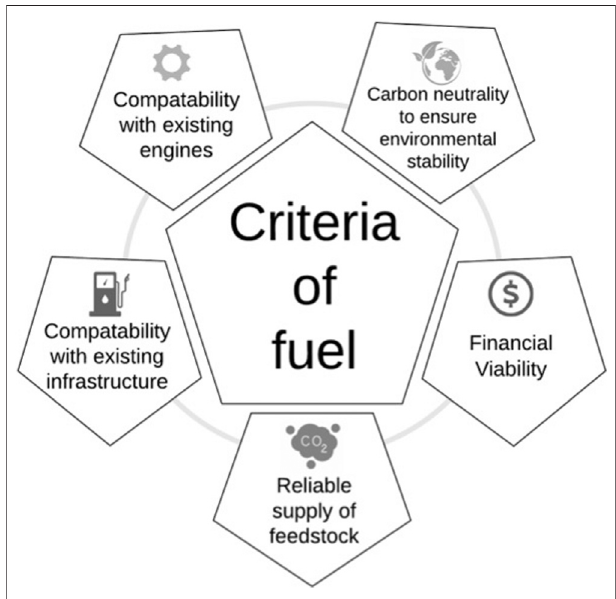
FIGURE 2 | The criteria of